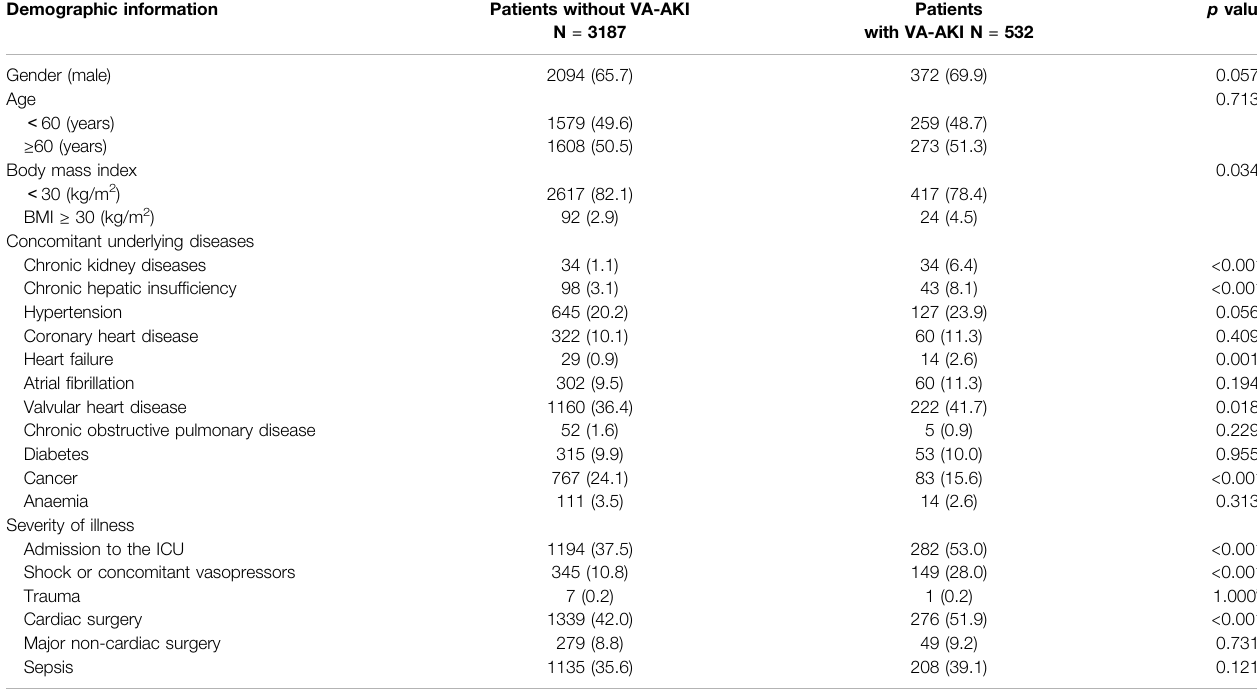
TABLE 1 | Demographic information and clinical characteristics of patients with and without VA-AKI. Demographic information Patients without VA-AKI